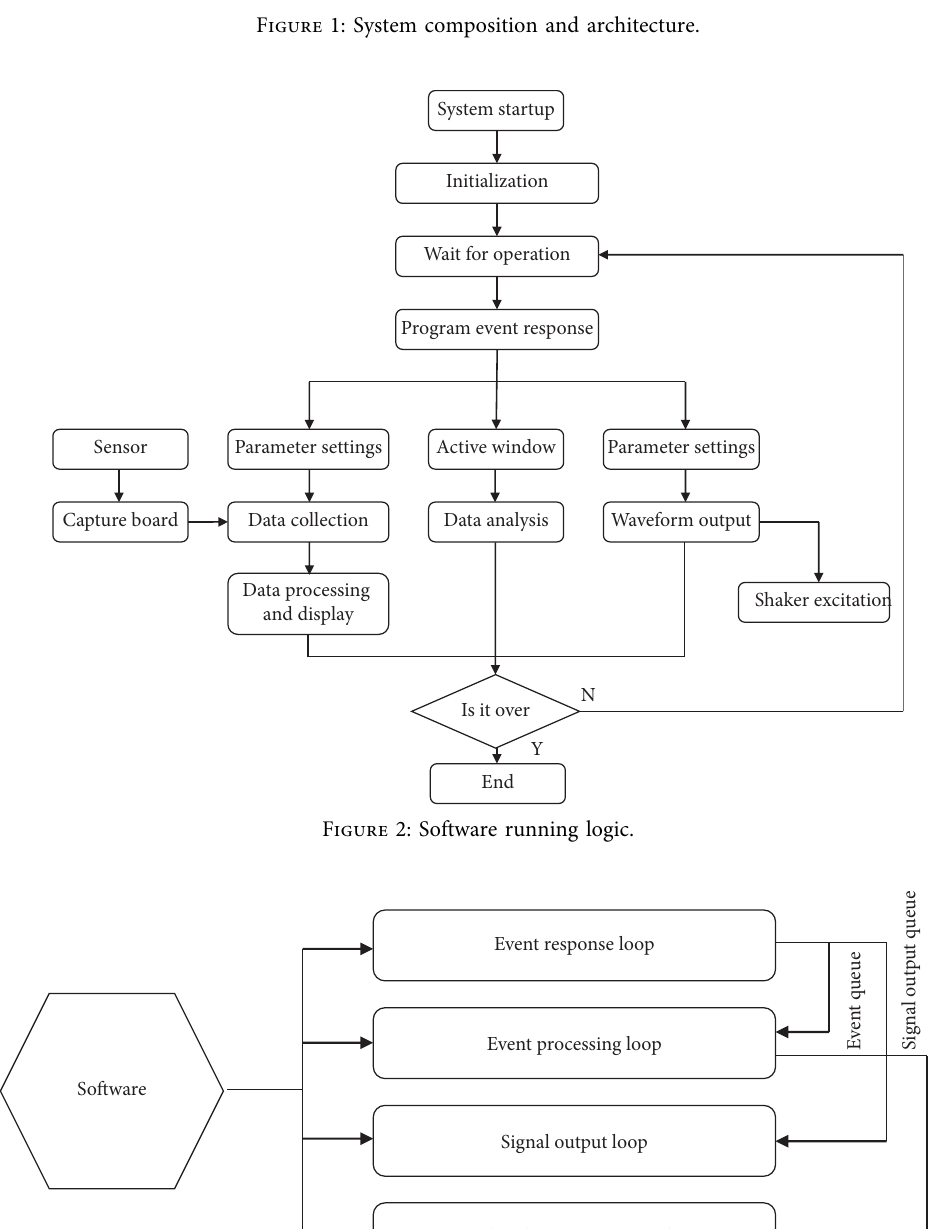
Figure 3: Multitasking framework of the software.